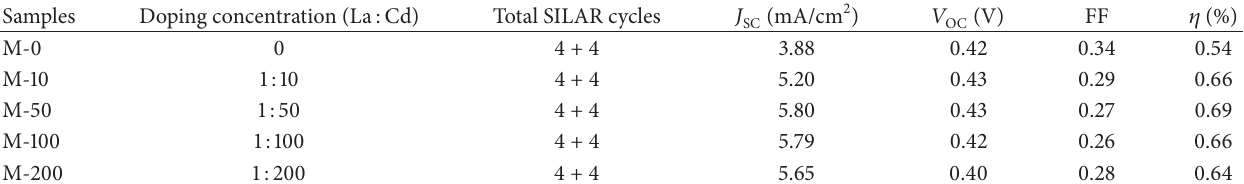
Table 1: Experiment parameters and sample calibration of different doping concentrations of La doped CdS.